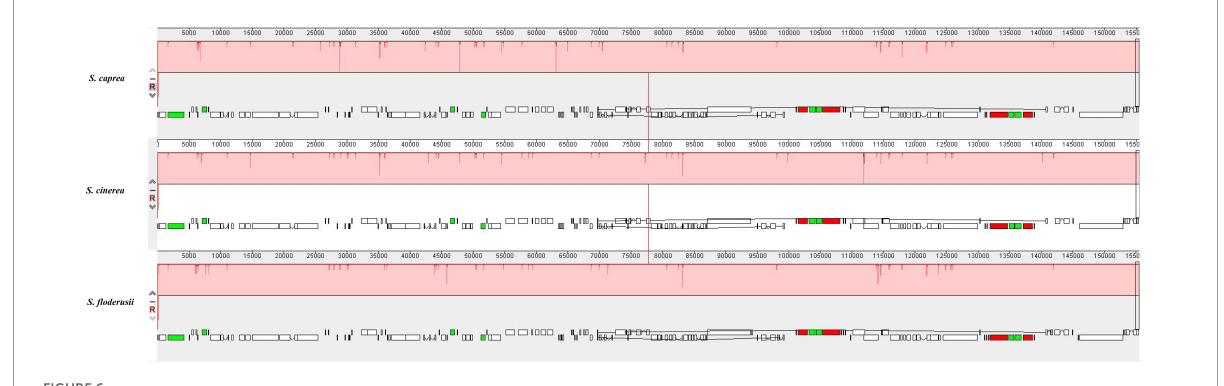
FIGURE6 Comparison of the genome structure of three species using the MAUVE program. The DNA sequences above the line are presented in a clockwise direction, and those below the line in a counterclockwise direction.